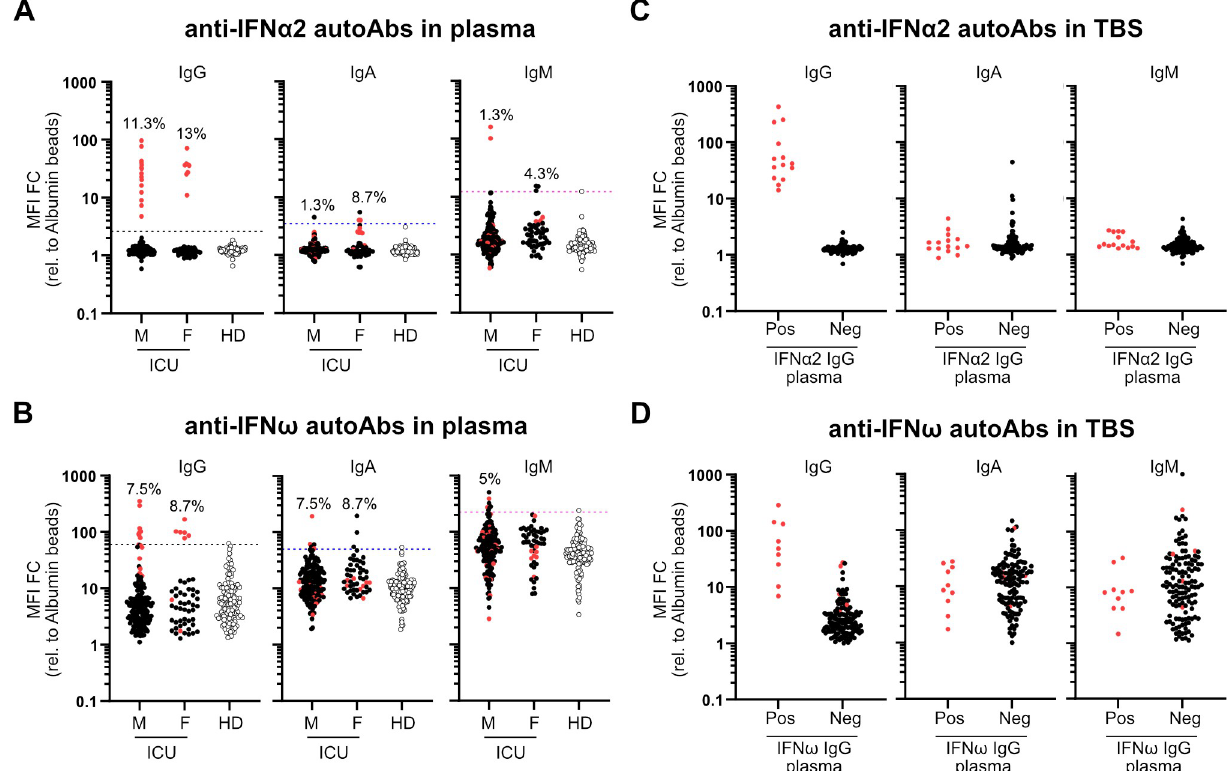
Fig 1. AU : AbbreviationlisthavebeencompiledforthoseusedinFigs 1 (cid:0) 3 ; S 1 ; andS 2 : Pleaseverifythatallentriesarecorrect : Autoantibodies targeting type I IFNs in the plasmas and tracheobronchial secretions of critically ill COVID-19 patients. (A and B) Multiplexed bead-based assay to detect IgG, IgA, and IgM autoAbs against IFN α 2 (A) or IFN ω (B) in plasmas of patients in ICU with severe COVID-19 (Male: M = 179 samples corresponding to 80 patients, Female: F = 51 samples corresponding to 23 patients) or Healthy Donors (HD = 130 samples). MFI FC of signal derived from IFN-coated beads relative to the MFI of signal derived from albumin-coated beads is shown. Dashed lines indicate 10 SDs (A) or 5 SDs (B) from the mean calculated from HD values for each IFN and each isotype. Values above the dashed lines are considered positive. Percentage of positive patients (not samples) per analyzed group is indicated. (C and D) Multiplexed bead-based assay to detect IgG, IgA, and IgM autoAbs against IFN α 2 (C) or IFN ω (D) in TBSs of COVID-19 ICU patients described in (A). Pos (positivity) and Neg (negativity) for anti-IFN α 2 IgG (C) or anti-IFN ω IgG (D) in plasma samples from the same patient were used to stratify patients. MFI FC of signal derived from IFN-coated beads relative to the MFI of signal derived from albumin-coated beads is shown. In all panels, red dots indicate the patients/samples that were positive for anti-IFN α 2 IgG autoAbs in plasma (A) and are denoted simply for reference. Data underlying this figure can be found in S1 Data. autoAbs, autoantibodies; COVID-19, Coronavirus Disease 2019; FC, fold change; HD, Healthy Donors; ICU, intensive care unit; IFN, interferon; MFI, median fluorescence intensity; SD, standard deviation; TBS, tracheobronchial